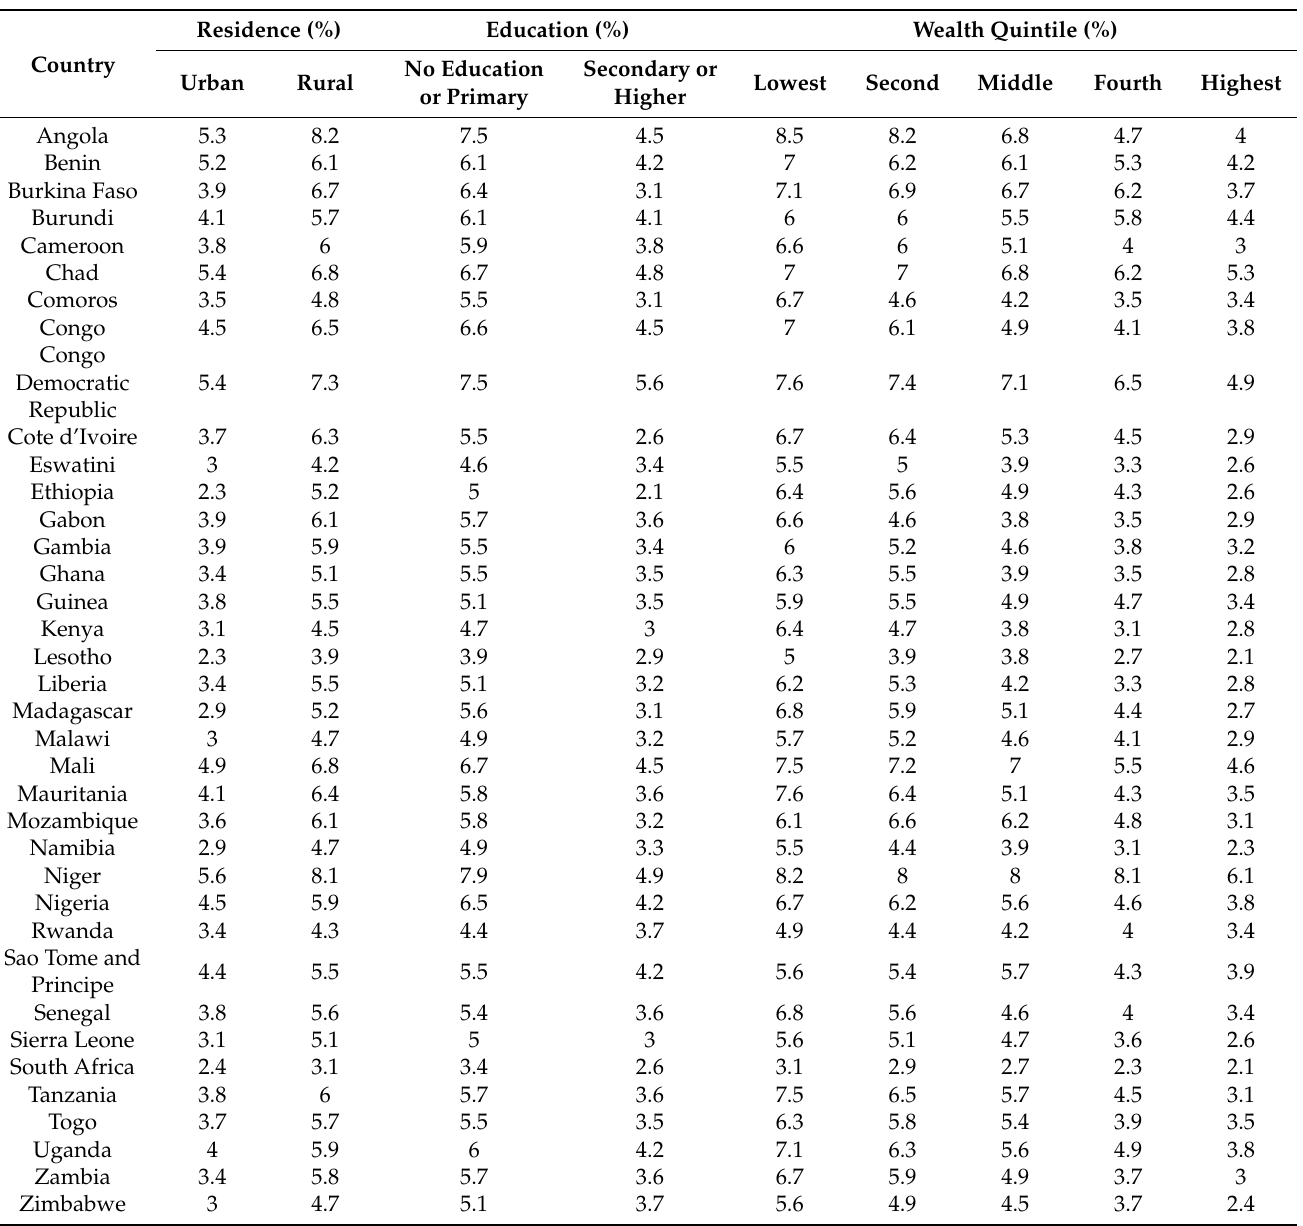
Table 5. Distribution of fertility rate among women in sub-Saharan